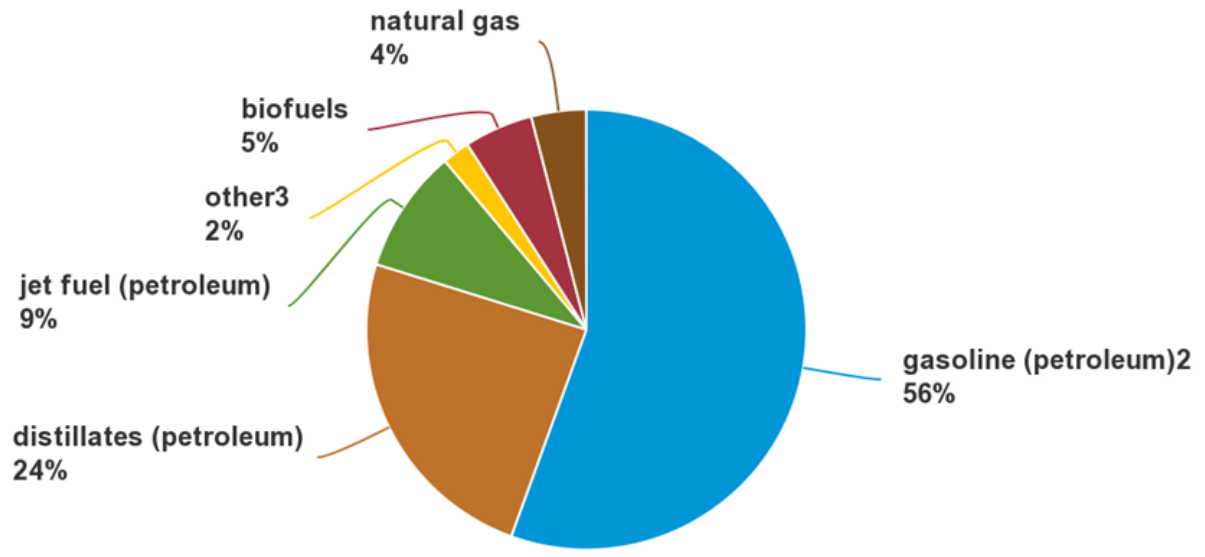
Figure 3. Transportation energy sources in the United States [38].